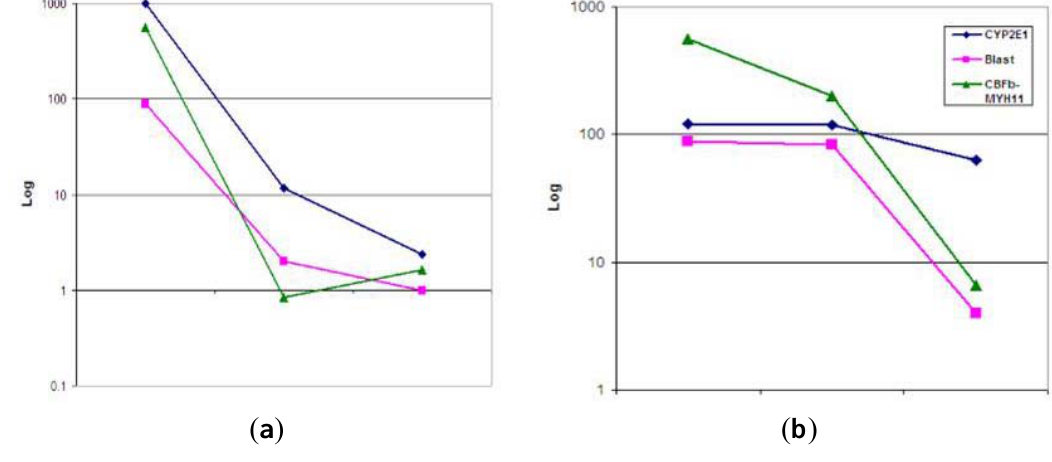
Figure 2. CYP2E1 mRNA expression in two different cases of AML with inv(16) ( a , b ) who were tested before (left test point) and 1 and 3 months after starting conventional chemotherapy with cytarabine